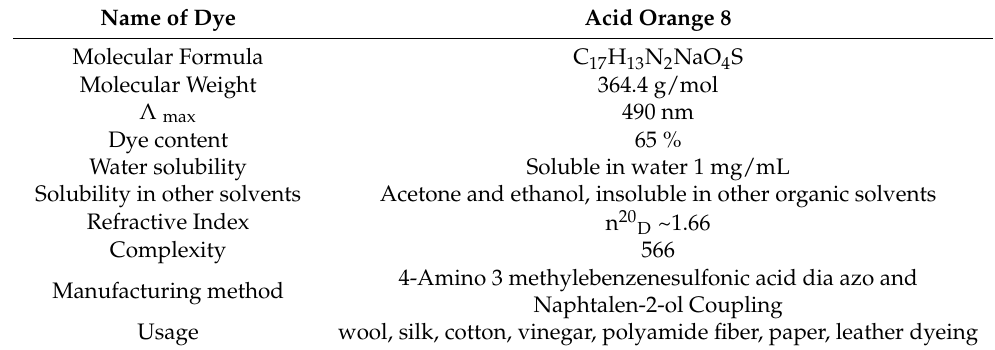
Figure 1. Structure of acid orange 8 (AO-8) . Table 1. Physiochemical properties of acid orange